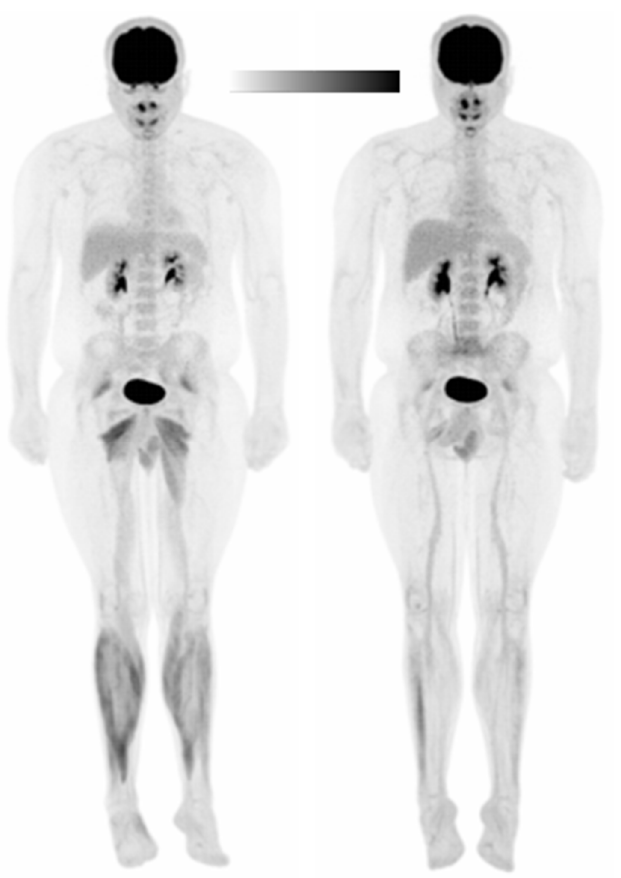
Figure 3. Whole-body maximum intensity projection (MIP) positron emission tomography (PET) image of Subject 1 in the SHAM ( left ) and tDCS ( right ) conditions. A scalar was applied to the tDCS image to normalize to the liver standardized uptake values (SUVs). Black denotes the greatest signal intensity, followed by gray, then white.